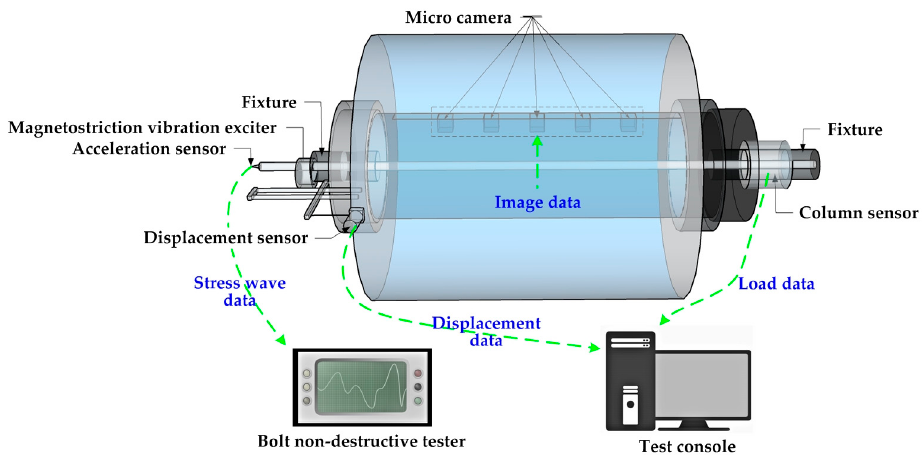
Figure 2. Schematic of the test system.